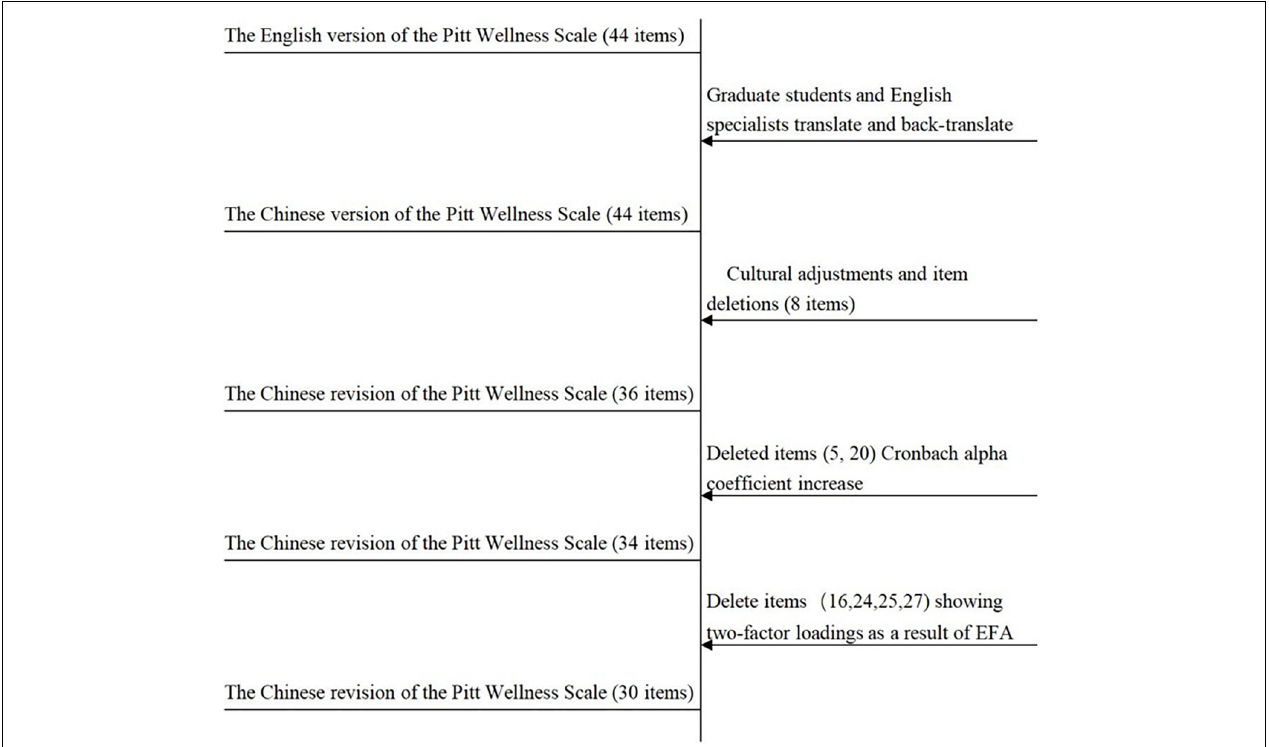
FIGURE 2 | China Revision of the Pitt Wellness Scale item deletion flow